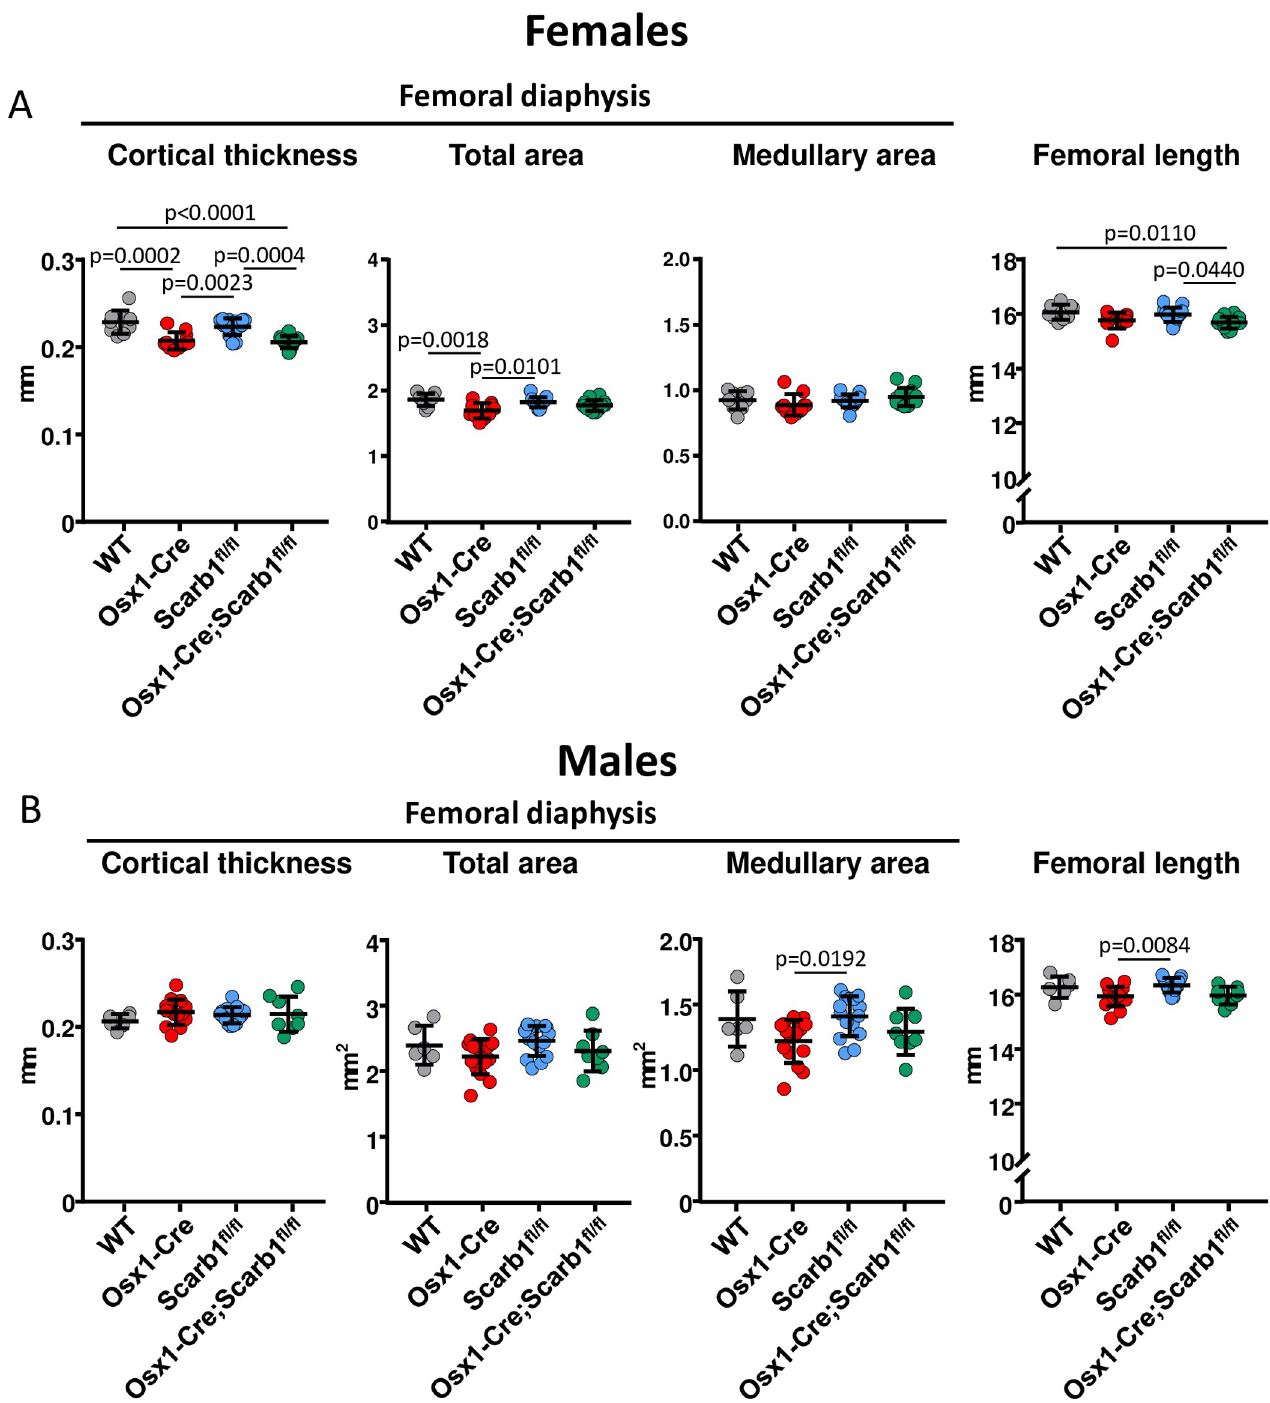
Fig 7. Deletion of Scarb1 using Osx1-Cre does not affect cortical bone in female or male mice. Micro-CT determination of cortical bone and femoral length in (A) 6-month-old female [WT n = 9; Osx1-Cre n = 10; Scarb1 fl/fl n = 13; Osx1-Cre;Scarb1 fl/fl n = 12], and (B) 7-month-old male mice [WT n = 6; Osx1-Cre n = 15; Scarb1 fl/fl n = 15; Osx1-Cre;Scarb1 fl/fl n = 8]. Data are shown as mean and standard deviation. Data analyzed by ANOVA, the p-values were adjusted using the Tukey’s pairwise comparison procedure. BV/TV, bone volume /total volume. Tb, trabecular.